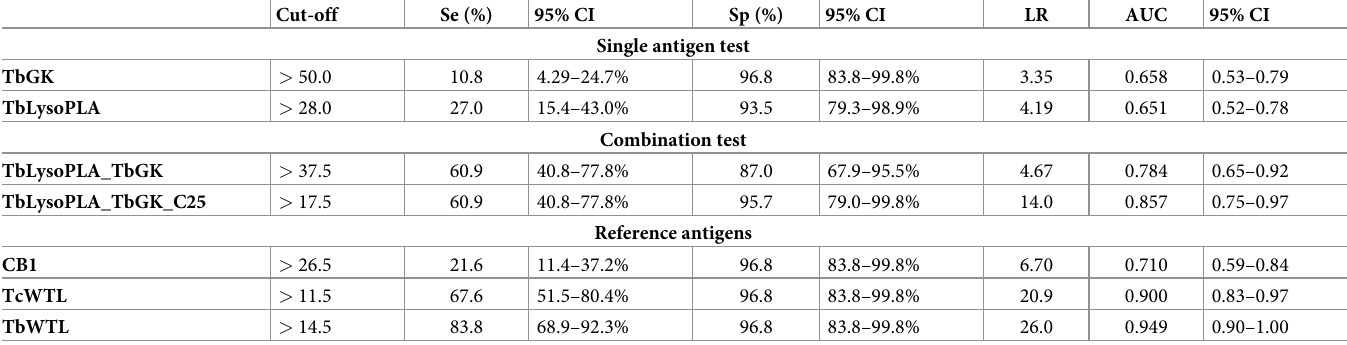
Table 5. Diagnostic performance parameters determined by ROC analysis of single antigen and mixture testings with field sera (sera from T . b . brucei , T . congolense and T . vivax infected cattle) in ELISA. Cut-off Se (%) 95% CI